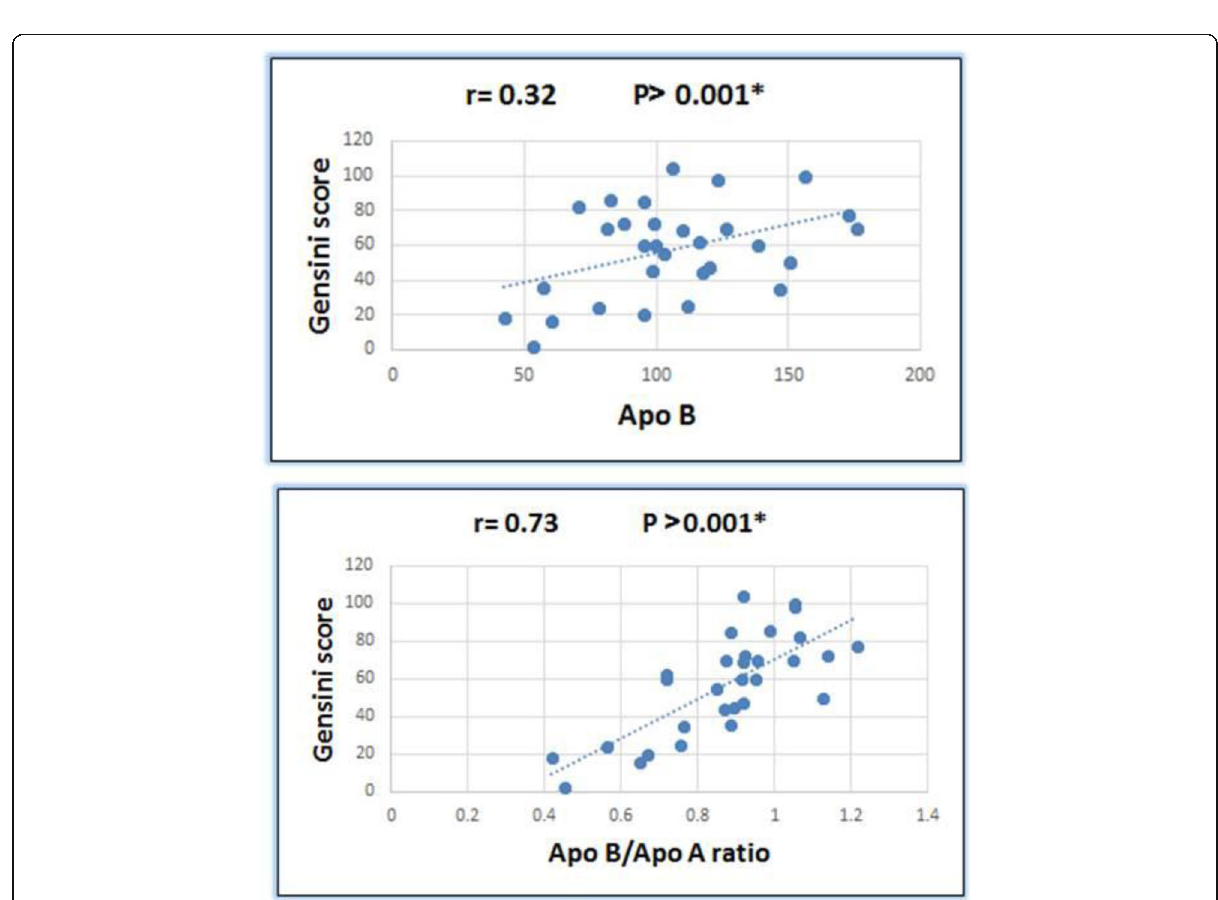
Fig. 3 Correlation between both Apo B, Apo B/Apo A ratio, and Gensini score in the studied